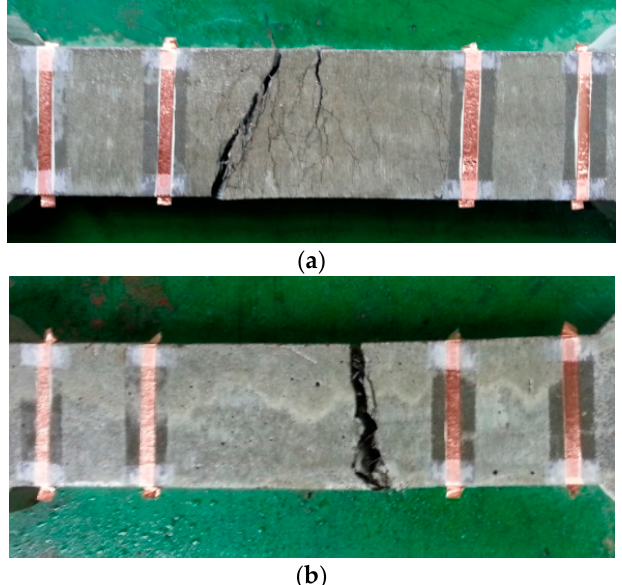
Figure 17. Representative cracking behavior of studied MSFRCs: ( a ) multiple tiny cracks for strain-hardening response; ( b ) single crack for strain-softening response.